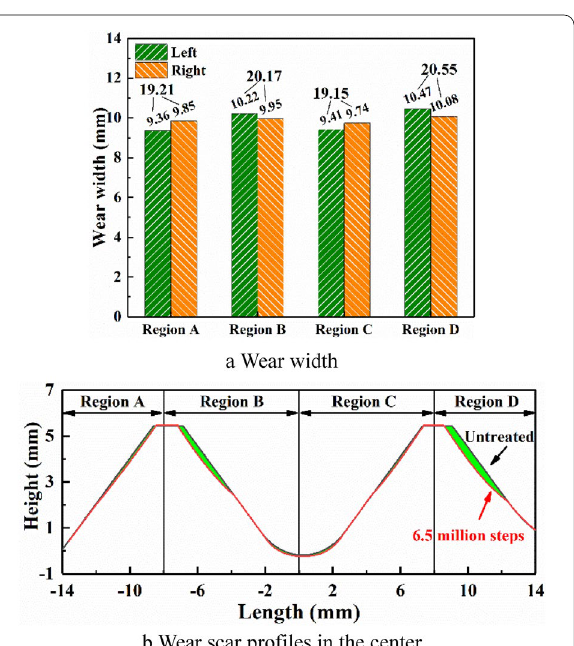
Figure 8 Wear dimensions on various claw